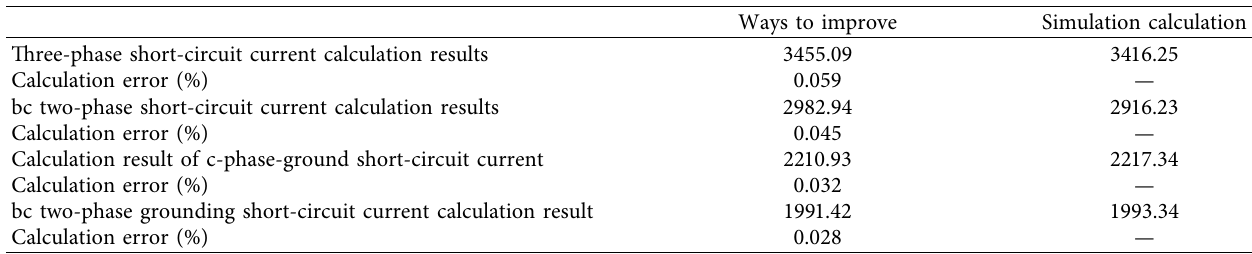
Table 3: Calculation results of short-circuit current in distributed power distribution network when two nodes fail.